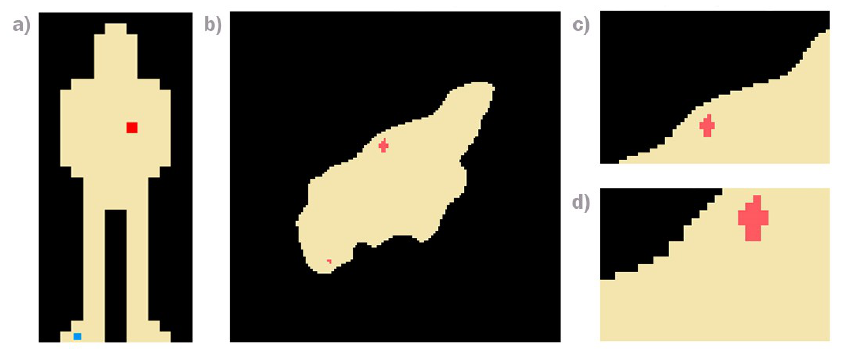
Figure 3. Example of synthetic images of four different RGB colors (Black, Yellow, Red and Blue) that simulate the background, medical suit, blood traces and camera position of the HORUS problem, respectively. Emulates: ( a ) least zoom, ( b , c ) intermediate zoom, ( d ) maximum